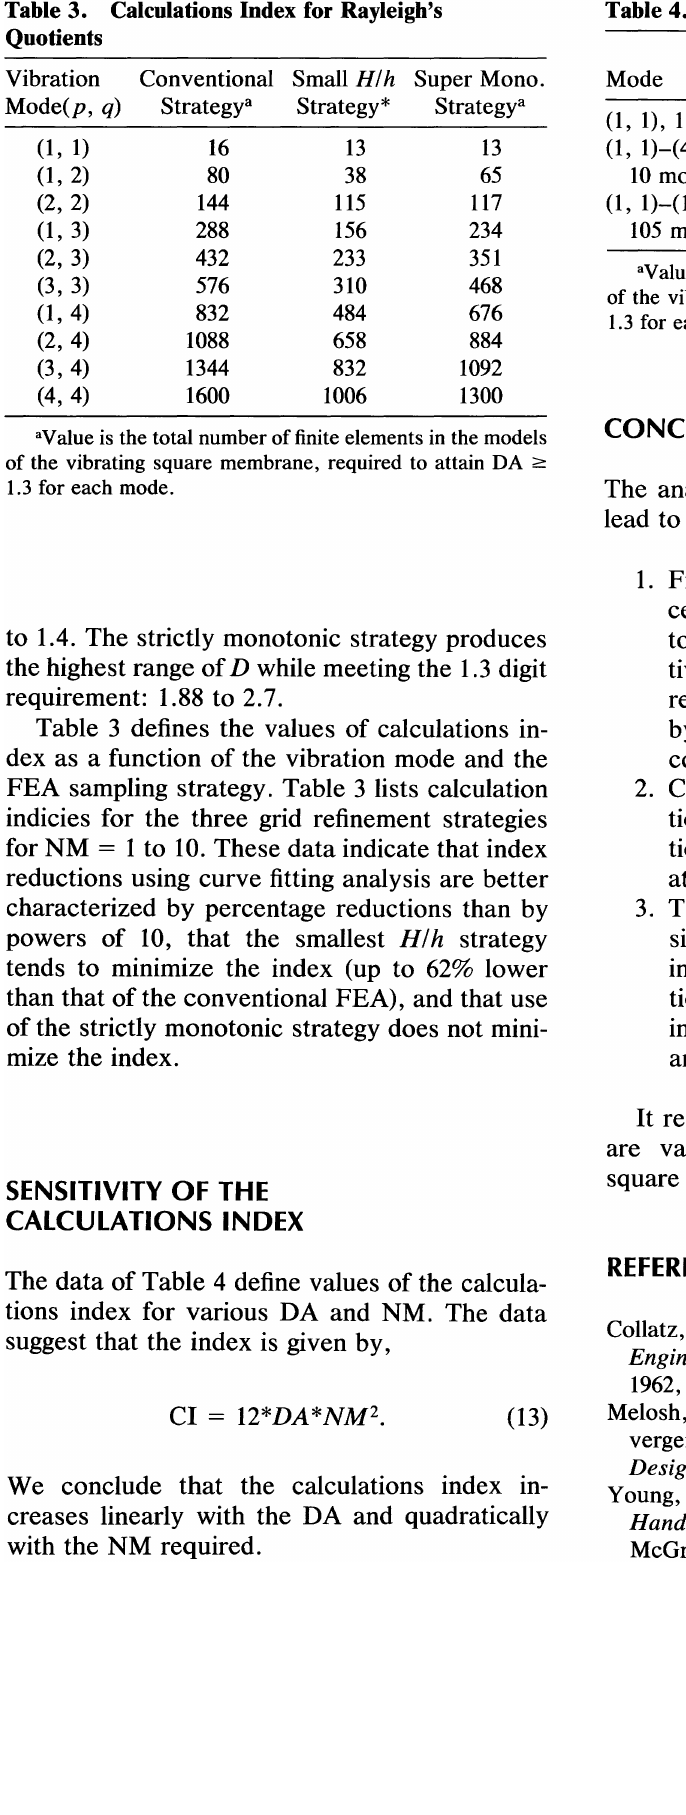
Table 3. Calculations Index for Rayleigh's Quotients